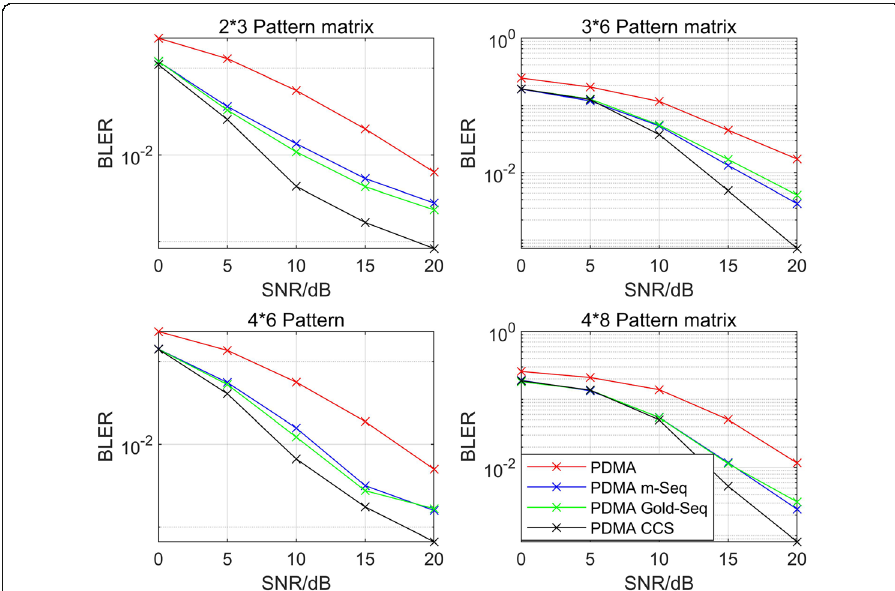
Fig. 8 Three spread spectrum sequences based on PDMA pattern matrix with different dimensions. The performance comparison of three spread spectrum sequences with different dimension pattern matrix. The m-sequence and Gold sequence adopt 6-order feedback coefficient, and the code length of CCS is 40. The dimension of pattern matrix is 2 (cid:5) 3